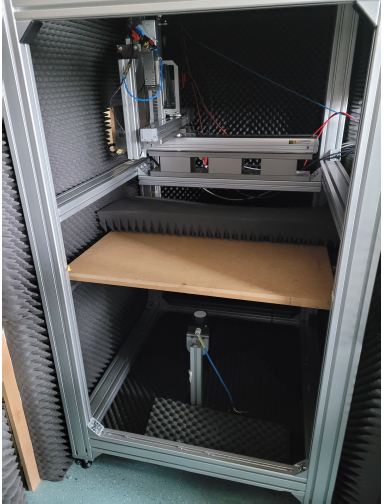
Figure 4. Experimental